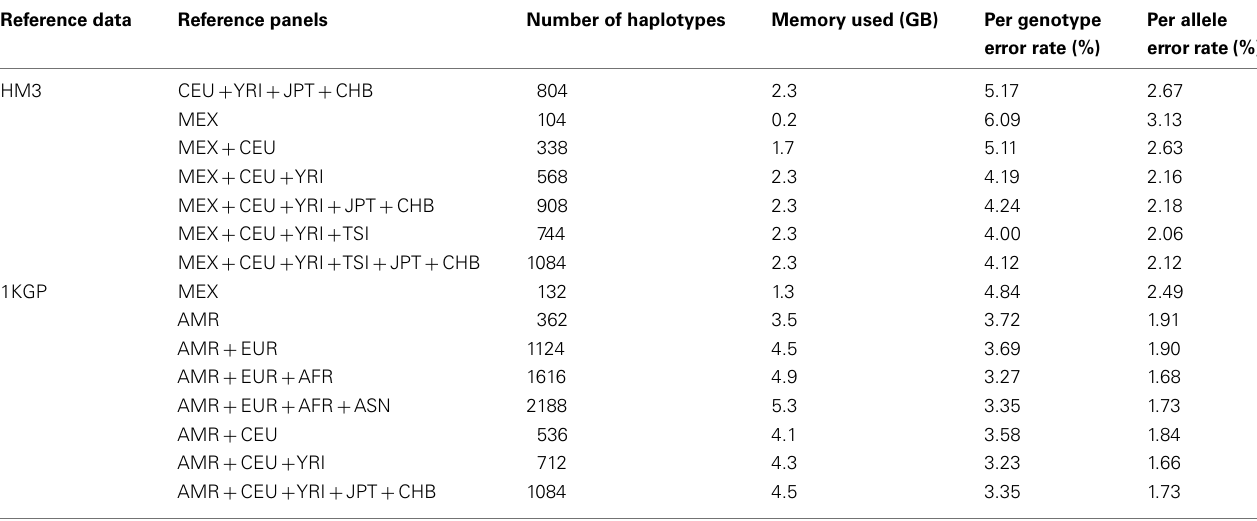
Table 2 | Genotype imputation accuracy for chromosome 22 based on the HM3 and 1KGP reference panels.